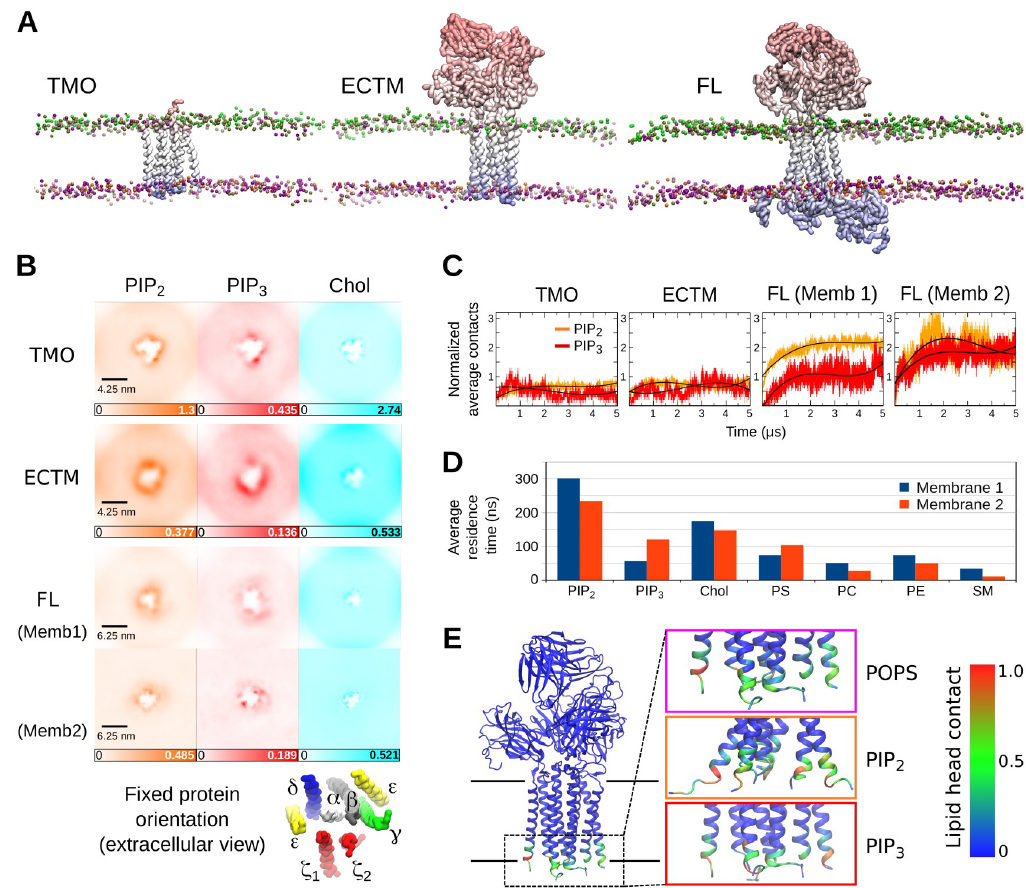
Fig 5. Cholesterol interactions and clustering of PIP lipids around the TCR-CD3. (A) Snapshots from the three sets of CGMD simulations (TMO, ECTM, FL) performed in this study. Here, only the protein and the lipid phosphate groups are shown for clarity. (B) Extracellular view of the densities of PIP 2 , PIP 3 and cholesterol molecules in the XY plane of the membrane from all five CGMD simulations combined. The protein was fixed in the center and its TMR orientation is shown below. (C) Normalized average number of PIP 2 and PIP 3 lipids contacting the protein in all CGMD simulations (TMO, ECTM, FL) versus time. Normalization was done by dividing the number of PIP 2 and PIP 3 lipid contacts by their respective number in the membrane. The smoothened black lines are a cubic regression of the number of PIP contacts across time. (D) Average residence time of all lipid types in membrane 1 and 2. (E) Interaction of the TCR-CD3 cationic anchor with anionic lipids mapped onto the ECTM